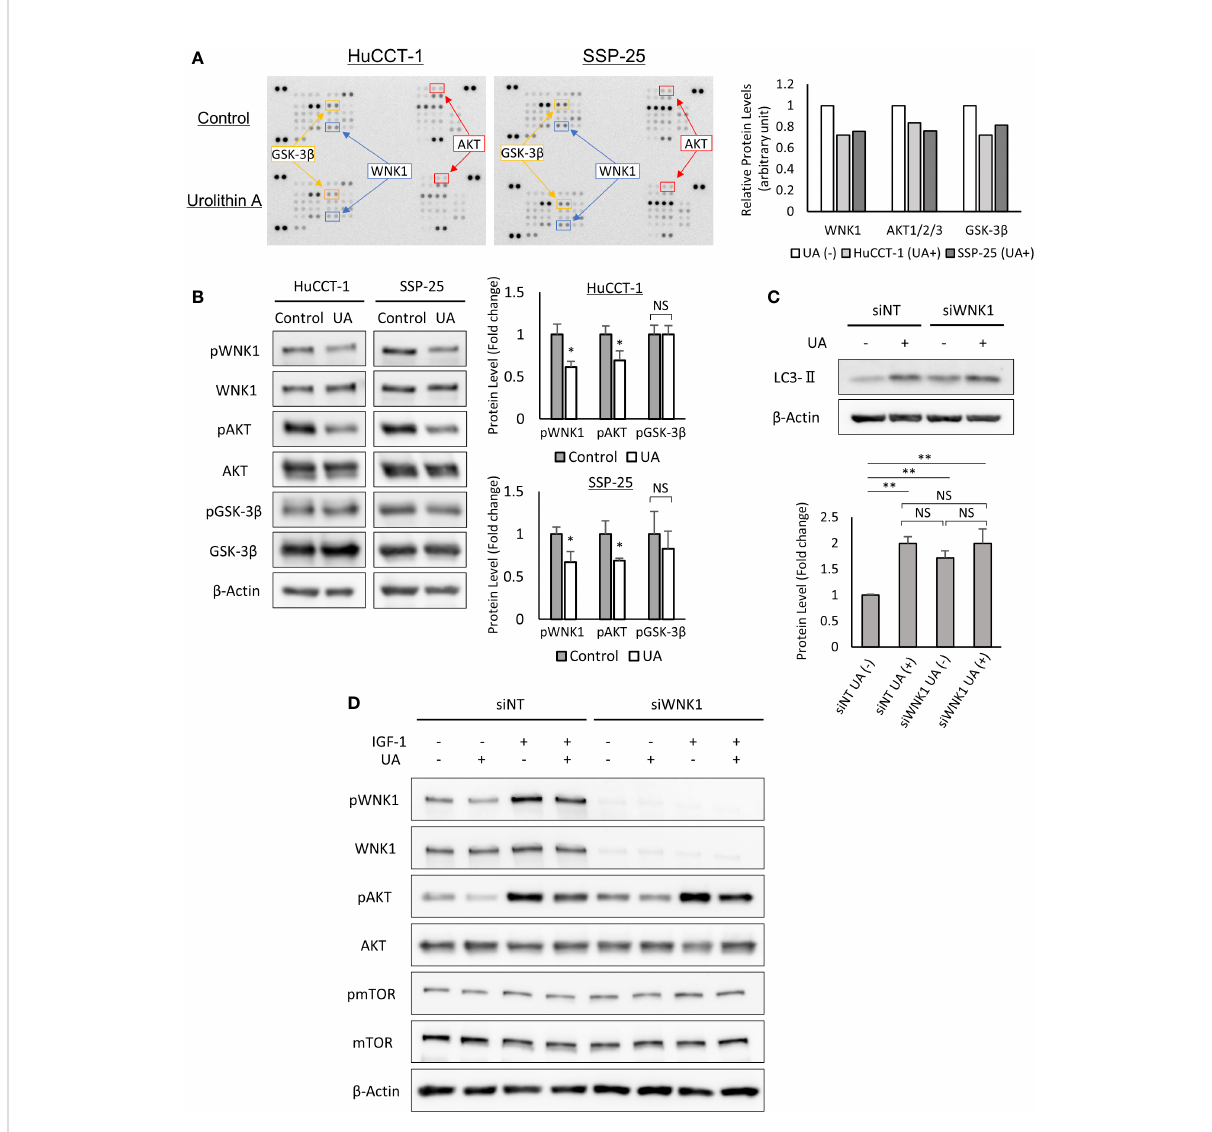
FIGURE 5 UA treatment downregulated AKT and WNK1 pathways, and induced autophagy in cholangiocarcinoma cells. (A) HuCCT-1 and SSP-25 cells were treated with 40 m mol/L UA for 3 h and analyzed using the human Phospho-Kinase array. Relative levels of protein phosphorylation (normalized intensity for each antibody) were quanti fi ed as a ratio of the UA-treated sample to the untreated one. (B) Results of the human Phospho-Kinase array were veri fi ed by Western blotting. b -actin was used as an internal loading control. Protein phosphorylation levels were normalized against b -Actin and represented the means of three independent experiments. Bars, standard deviation; NS, not signi fi cant; *P < 0.05. (C) Western blotting for LC3-II in WNK1 knocked down HuCCT-1 cells. Cells were treated with 40 m mol/L UA for 24 h b -actin was used as an internal loading control. LC3-II levels were normalized against b -Actin and represented the means of three independent experiments. Bars, standard deviation; NS, not signi fi cant; **P < 0.01. (D) Western blotting for WNK1 (Thr60 and total), mTOR (Ser2448 and total), and AKT (Ser473 and total) in HuCCT-1 cells transfected with control (siNT) or WNK1-speci fi c (siWNK1) small interfering RNAs. Cells were treated with 40 m mol/L UA and 50 ng/mL IGF-1 for 3